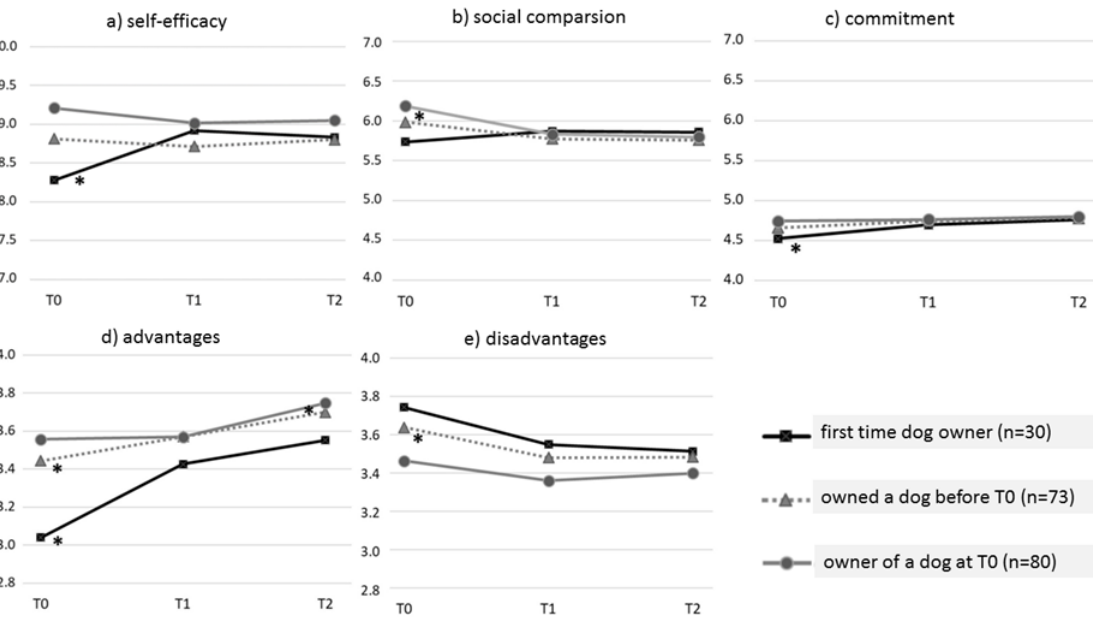
Figure 2. Changes over time for ( a ) self-efficacy, ( b ) social comparison, ( c ) commitment, ( d ) advantages, and ( e ) disadvantages in the three dog owning history groups. An asterix (* placed below the line) indicates a significant increase or decline between the two time points.